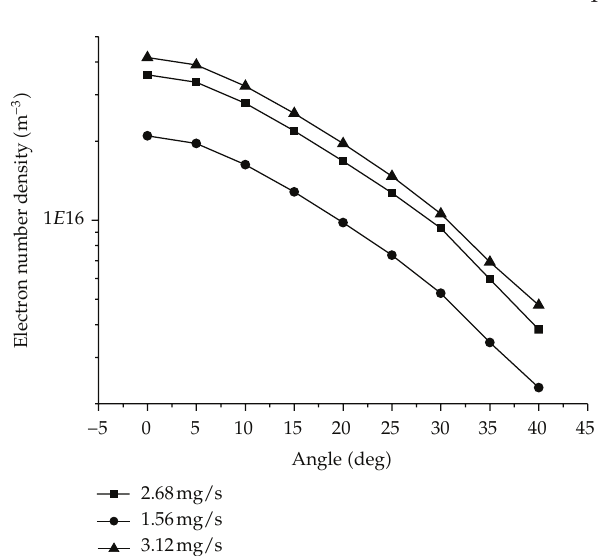
Figure 9: Electron density at L (cid:9) 25cm for di ff erent mass flow rates.